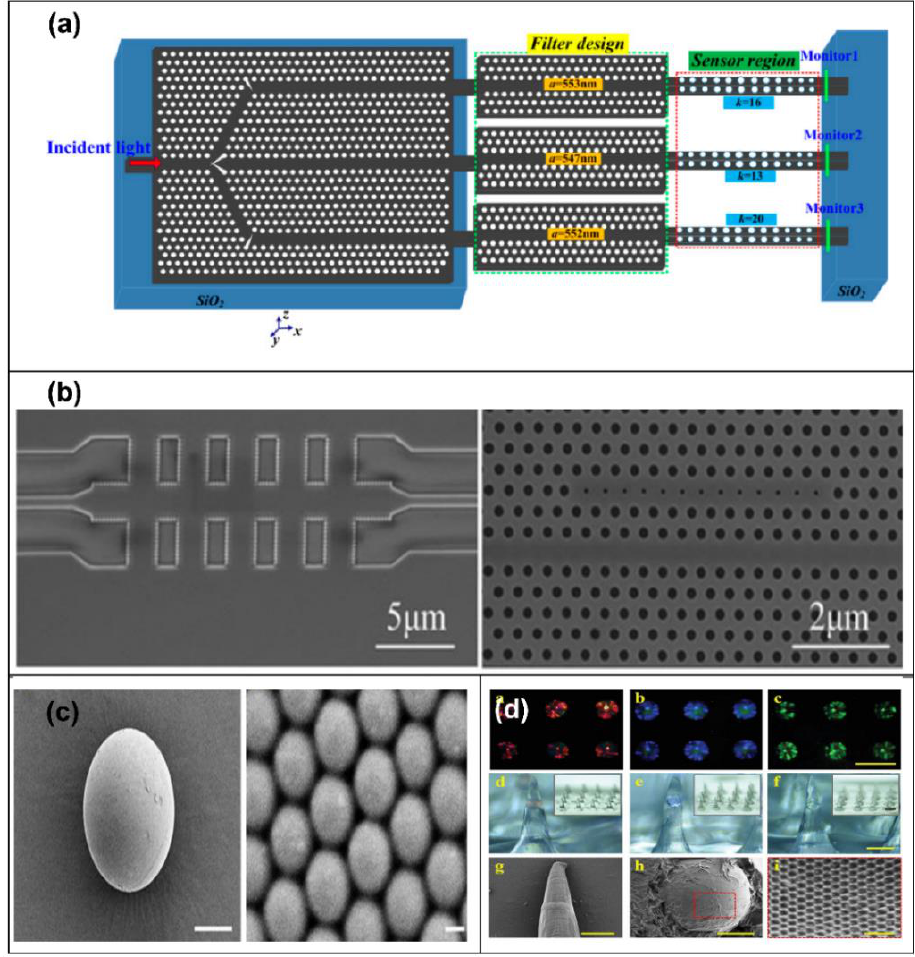
Figure 9. Two- and three-dimensional PhCs: ( a ) Schematic of the PhC’s parallel integrated sensor array on the monolithic substrate. ( b ) Scanning electron microscope images of the waveguide crossings and PhCs microcavities. ( c ) SEM image of the surface of the PhC microsphere and the ordered hexagonal arrangement of monodisperse silica nanoparticles. ( d ) Optical and SEM images of the one-barcode-loaded microneedle array. ( a ) Reprinted with permission from [113], copyright 2016, MDPI. ( b ) Reprinted with permission from [114], copyright 2016, SPIE. ( c ) Reprinted with permission from [115], copyright 2020, the American Chemical Society. ( d ) Reprinted with permission from [116], copyright 2019,